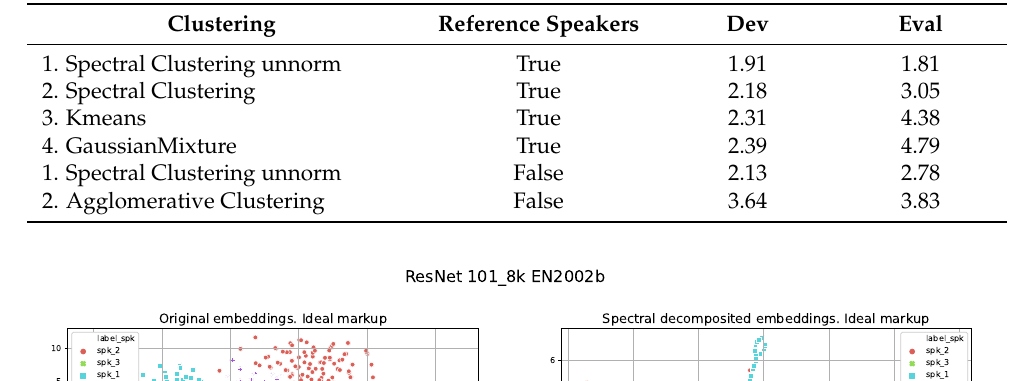
Table 4. Results of comparing the clustering algorithms for the AMI Development and Evaluation sets (dev/eval) in terms of DER (%) for the reference and the estimated number of speakers in each single recording. The methods are numbered according to their presentation in Section 4.3. Lower error values are better. Clustering Reference Speakers Dev Eval